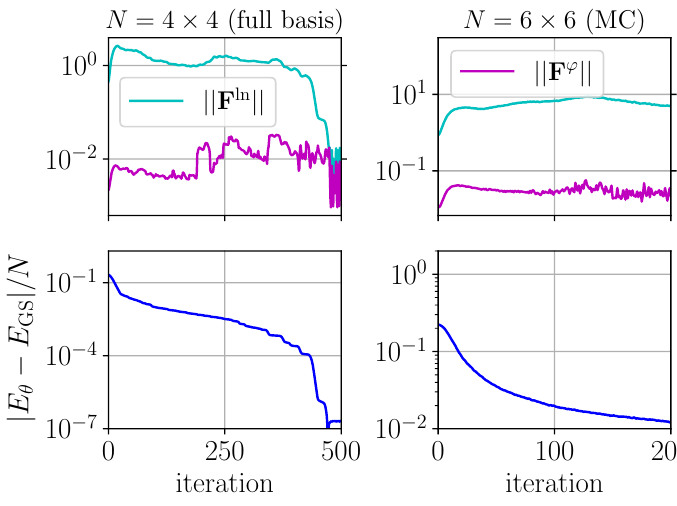
|| separated into a log-amplitude Figure 2: Top row: the norm of the force vector || F k and phase contributions shows the large difference between the two in the initial stages of optimization. Bottom row: the corresponding energy optimization curves. Left column: full-basis simulation for N = 4 × 4. Right column: C simulation at = 2 15 samples. The log-amplitude contribution to the gradients N = 6 × 6 with N MC dominates over the phase contribution at the early optimization stages: since the two contributions enter additively in the network update vector, this might lead to an op- / J = 0.5 (until timization bias, and prevent learning the correct sign structure at J 2 1 very deep in the optimization landscape). The AF Marshall-Peierls rule is incorpo- rated into the ansatz through a gauge choice. The network architecture used is listed in App. H. Optimization was done using RK in combination with SR, see App.